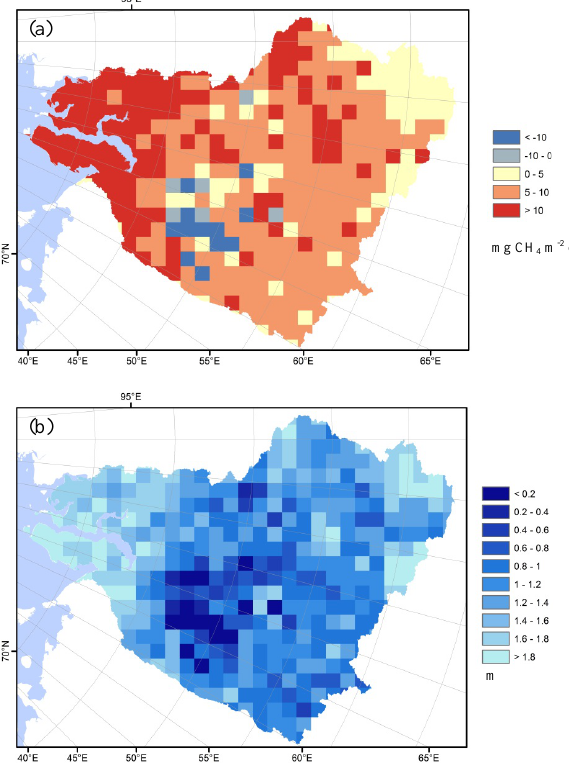
Fig. 6. The difference in mean methane fluxes between 5km and 100km simulations (a) , and simulated 100km mean water table depth (b) , during the growing season (May–September) across the West Siberian